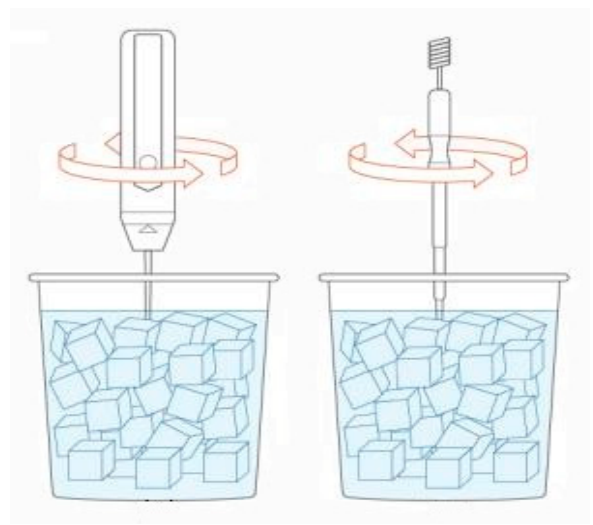
Figure 2. Submerge procedure of the reference sensor and the sensor that is going to be calibrated. Initially, we gently stir and submerge the reference sensor, as seen in the left image. Then, we stir and submerge the sensor that is going to be calibrated (right image).